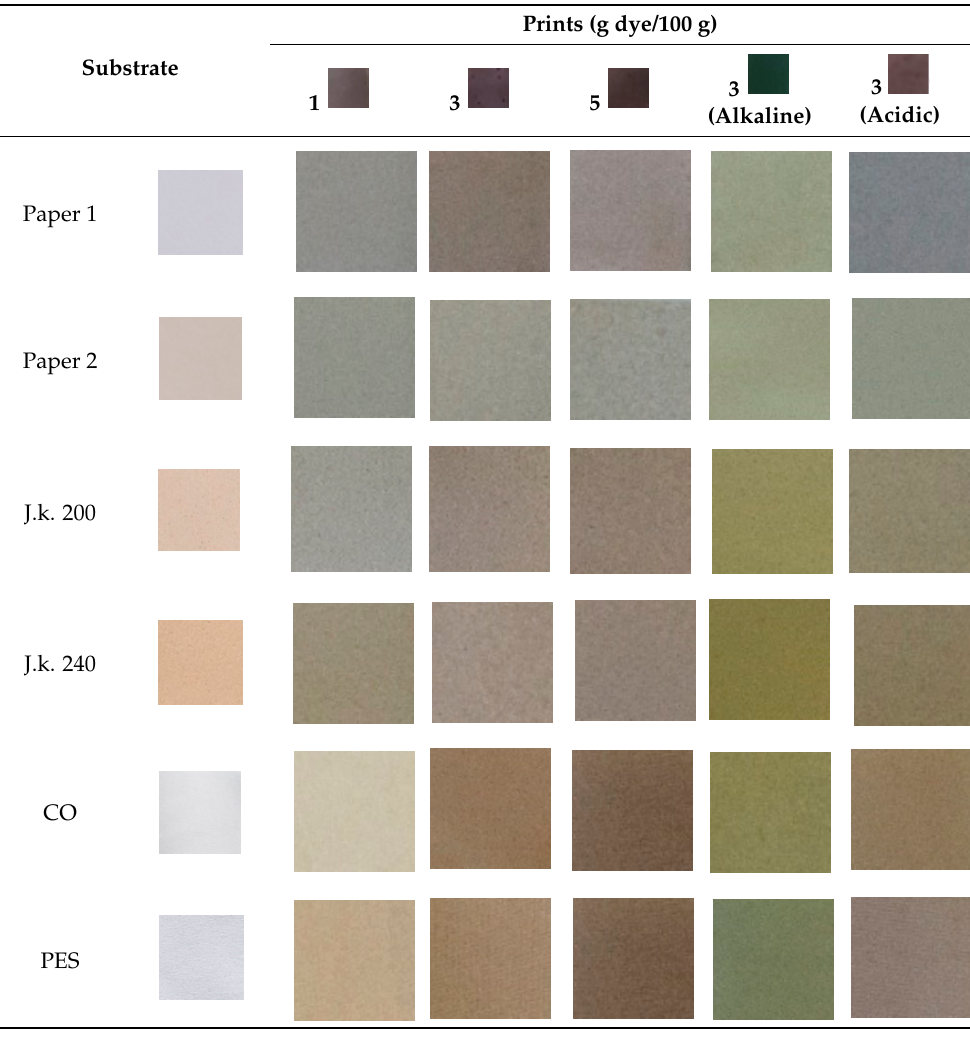
Table 2. Photographs of substrates and prints.